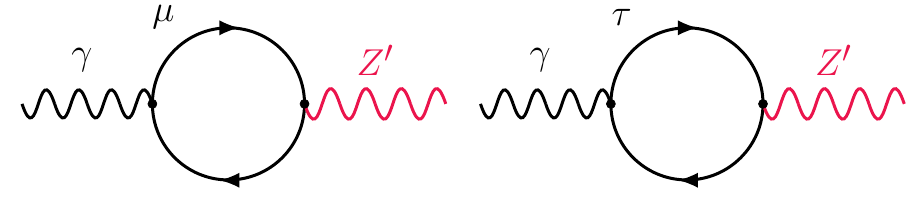
Figure 1 . Feynman diagrams that lead to kinetic mixing between the Z 0 and the photon. In addition to the diagrams shown here, there could also be model dependent contributions that arise from heavy states charged under both electromagnetism and U(1) L additional contributions from heavy physics beyond the SM, see appendix